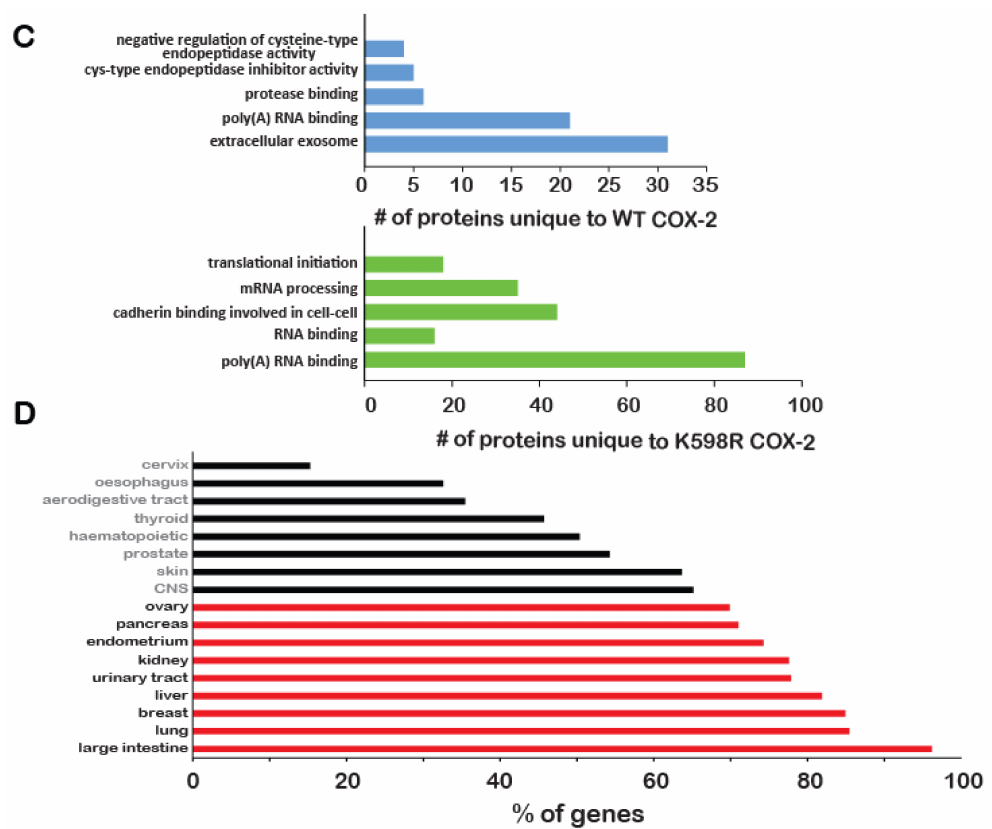
Figure 5. E ff ect of K598R COX-2 on RNA and protein expression. HEK 293 cells expressing either Mock, WT or K598R COX-2 were subject to transcriptome and proteome analyses. ( A ) Graph depicting GO enrichment analysis of K598R compared to WT COX-2 ( n = 3 replicas of each transfection). Presented GO terms were significantly enriched (BH adjusted p -value < 0.05) in both upregulated and downregulated subsets of di ff erentially expressed genes. ( B ) Venn diagrams of proteins interacting with WT, K598R or both in cytosolic and nuclear fragments ( n = 3 replicas of each transfection). ( C ) Graph depicting the GO terms of proteins that interact specifically with WT (Top) or K598R (Bottom) COX-2. ( D ) Graph depicting the percent of genes identified in the transcriptomics data as uniquely regulated in the K598R COX-2 samples involved in di ff erent types of